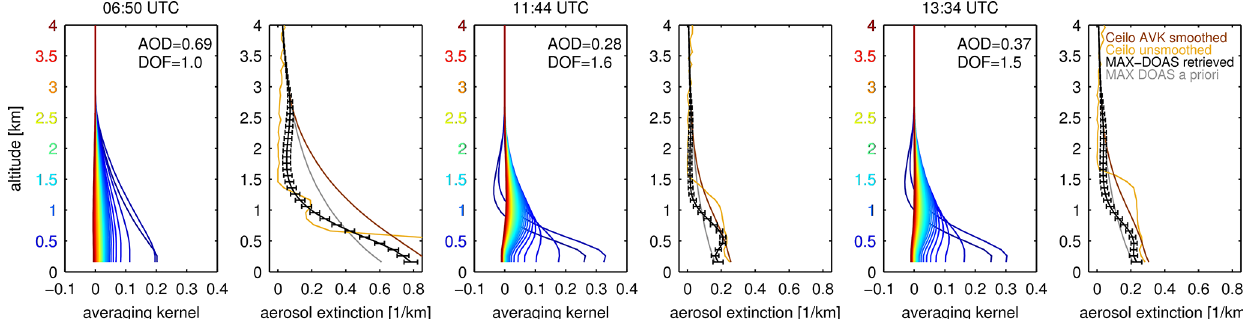
Figure 2. Exemplary averaging kernels for the retrieved aerosol extinction in the UV channel (MAX-DOAS: 338–370nm, ceilometer: 360nm) for the morning (06:50UTC), noon (11:44UTC), and afternoon (13:34UTC) of 10 October 2018. Altitudes and corresponding AVK lines are associated with a color. Also shown are the respective MAX-DOAS a priori (gray lines), MAX-DOAS retrieved (black lines), ceilometer unsmoothed (orange lines), and ceilometer AVK smoothed (brown lines) vertical AE profiles. The error bars of the MAX-DOAS- retrieved vertical AE profiles represent the total error of the BOREAS aerosol retrieval. Degrees of freedom of signal (DOFs) are given for each individual AVKs. The respective AOD values are obtained from AERONET measurements.